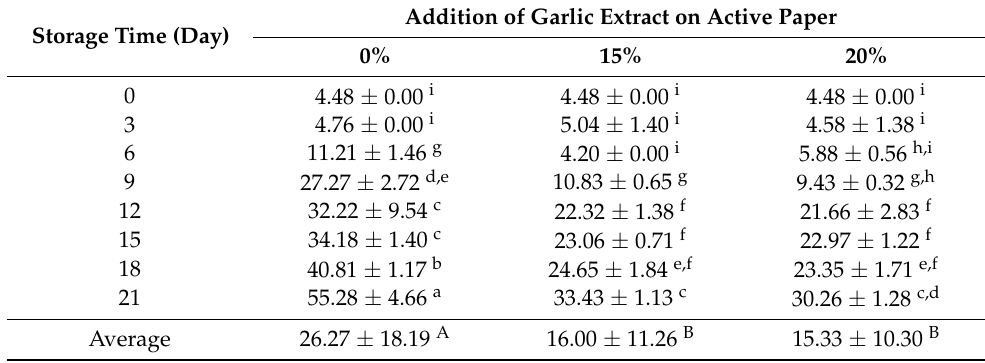
Table 2. The TVBN value of packaged meat samples stored in cold storage for 21 days. Storage Time (Day)